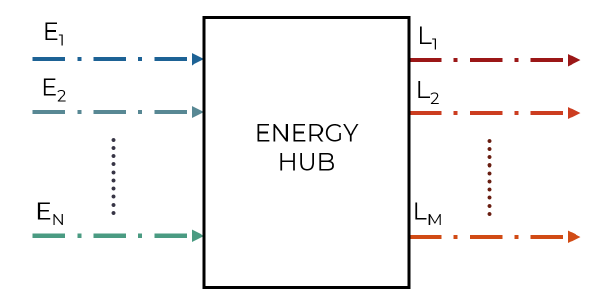
Figure 1. General model of an energy